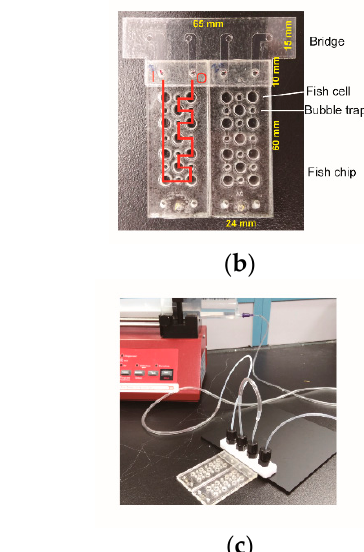
Figure 5. Fish chip with Lego concept. ( a ) Schematic diagram showing the components and assembly of DK2 port, bridge, and fish chip. Double adhesive films were cut with a computer-controlled cutter to form U2-2x-b, U4-2x-t, 2x-m, 2x-cb. 2x-m, and 2x-bp. Transparency films were similarly cut to form tr-c and tr-p. Four gates (g1~g4) were formed by attaching tube connectors to PTFE. Tubes were inserted into the ferrule plugs and firmly attached to the gates by tightening screw caps. ( b ) A bridge with two fish chips. The red line indicates the input (I) and output (O) path of fluid flow in the chip channels. ( c ) A functional chip array. A syringe pump continuously injected fresh normal phosphate buffer saline to the fish cells where fish embryos had been placed. The rate of fluid flow was 5